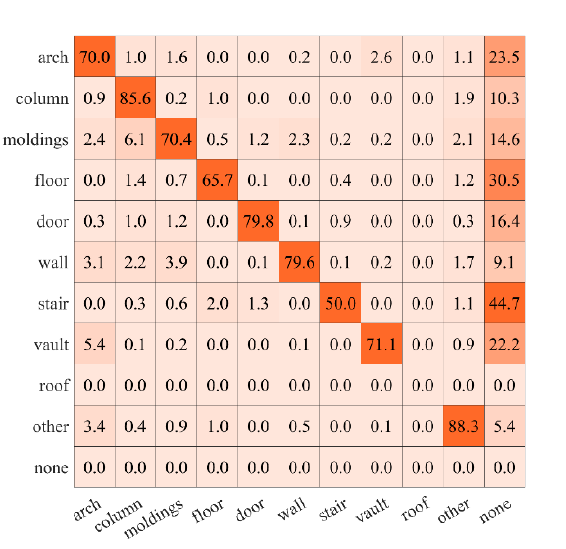
Figure 9 . Confusion Matrix for 3_SSA back-projection.